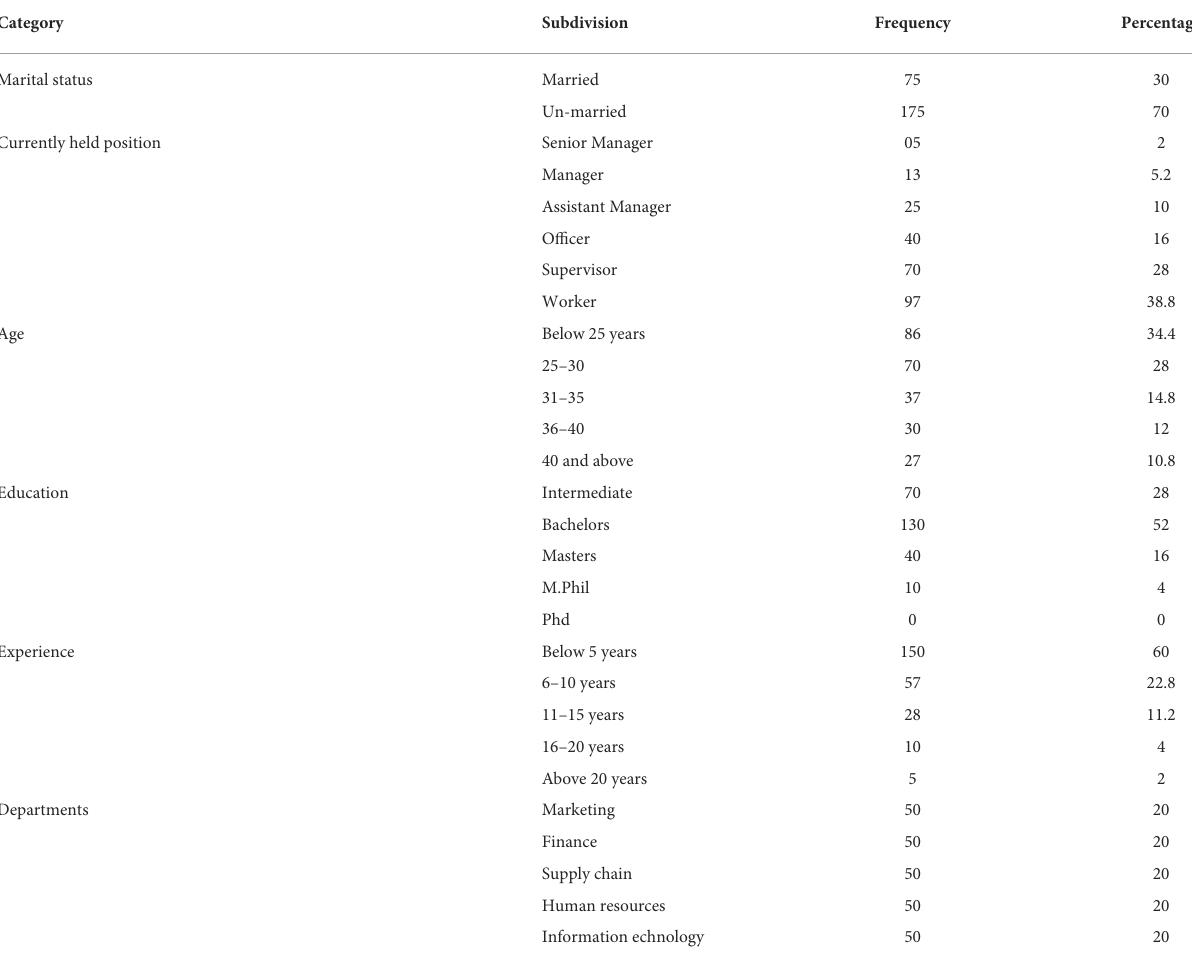
TABLE 1 Demographic profile of the respondents.